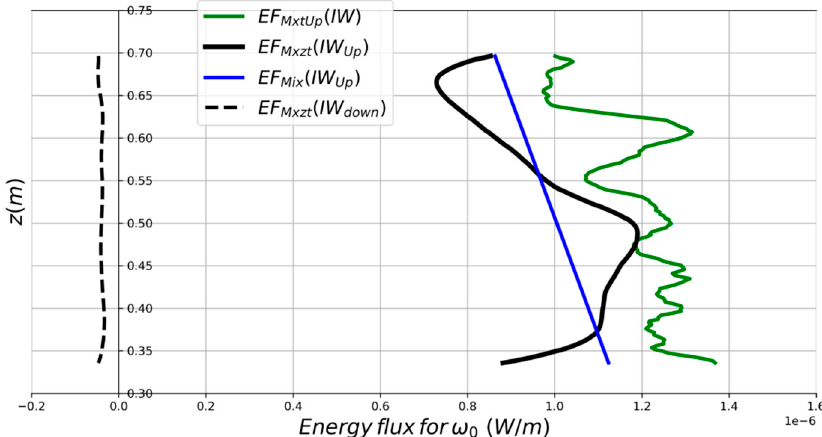
Figure 10. Spectrum of 𝛿𝑁 (cid:2870) as a function of 𝑚 for 𝑘 = 𝑘 (cid:2868) and 𝜔 = 𝜔 (cid:2868) . The plain line represents (cid:3555)(cid:3563)(cid:3563) (cid:3628) ) whereas the dotted line represents the spectrum of the filtered the spectrum of the raw data ( (cid:3628)𝛿𝑁 (cid:2870) data (without the downward propagation). The red vertical line indicates the value of m 0 .